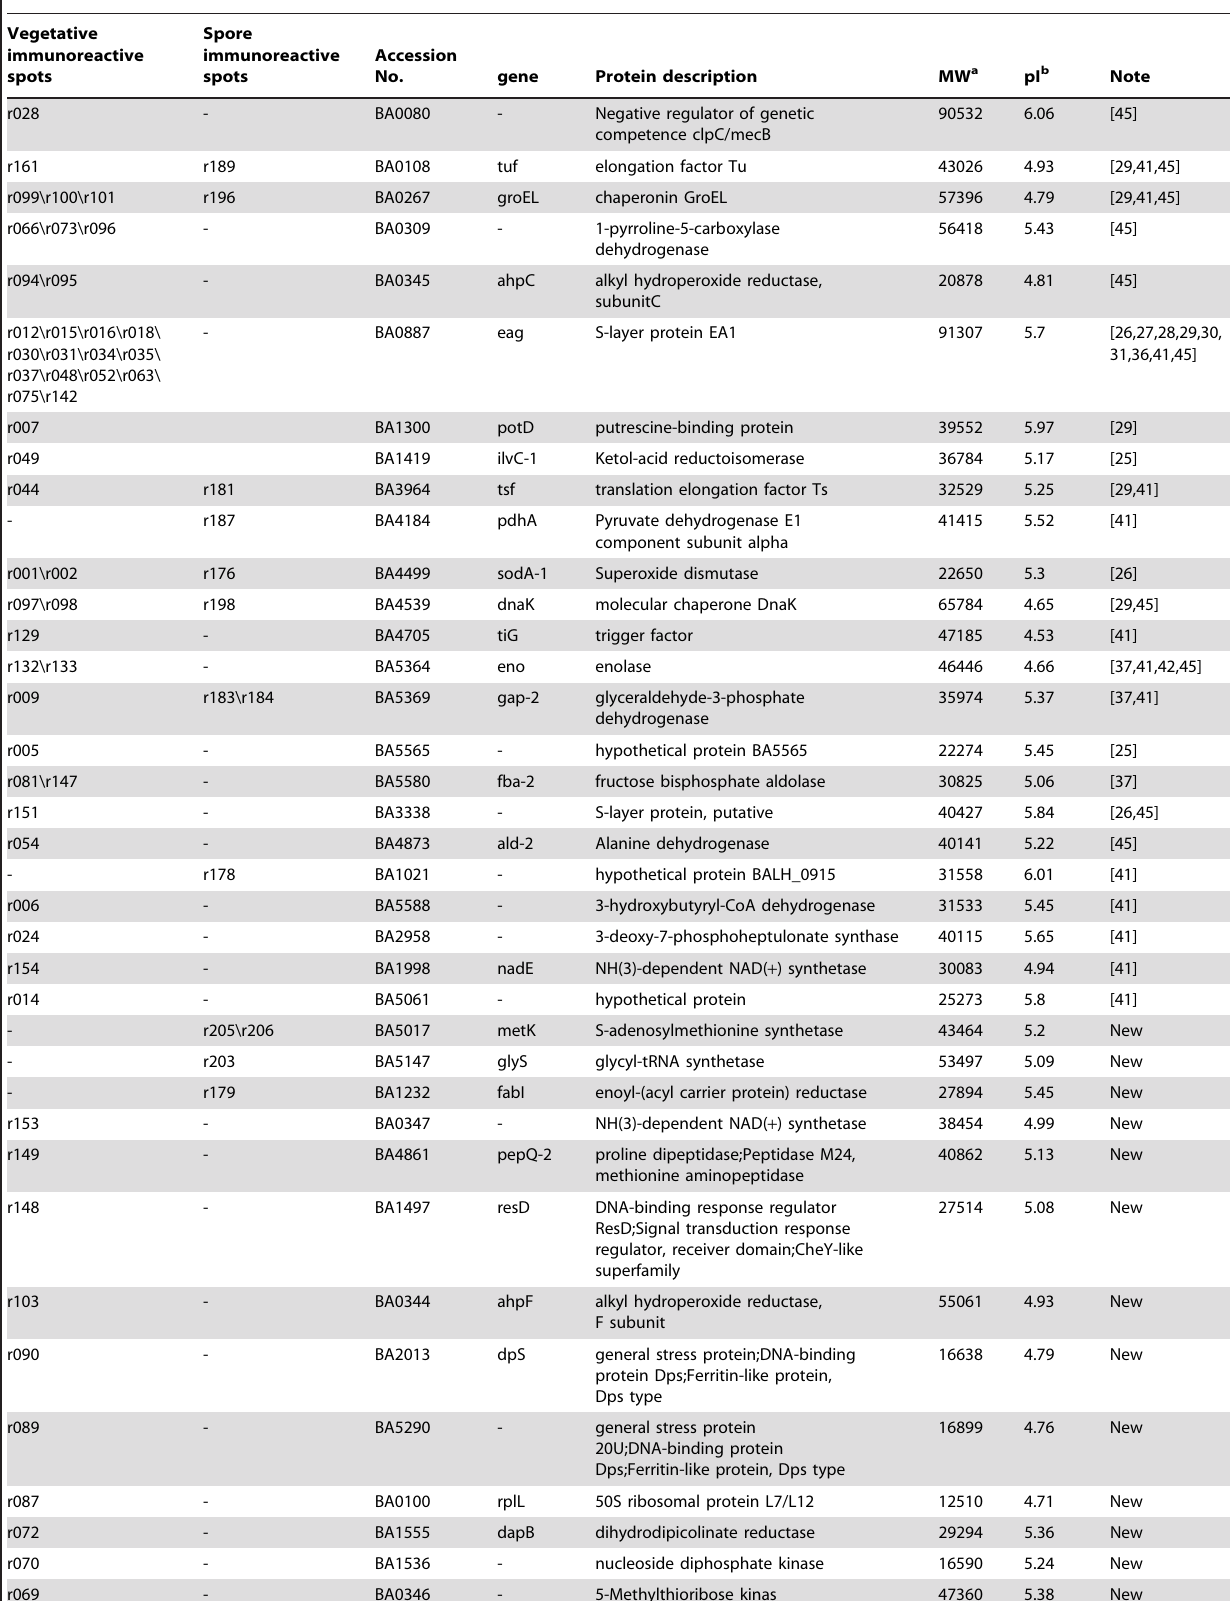
Table 1. Immunogenic proteins identified in this study.